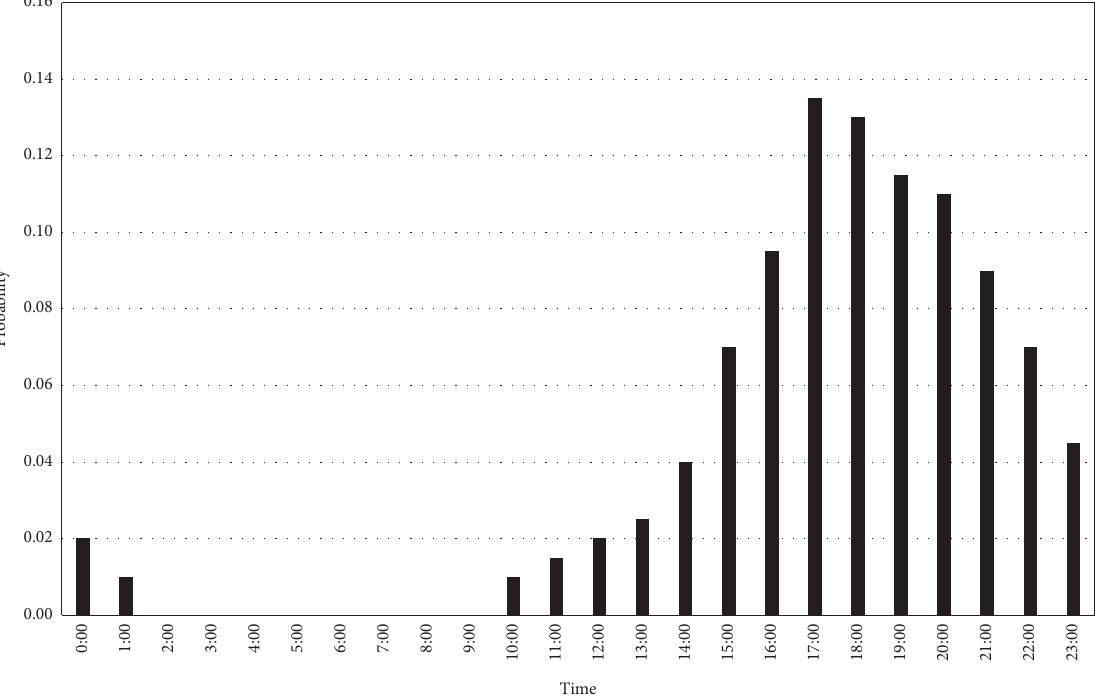
Figure 2: Probability density function of the start time of charging.